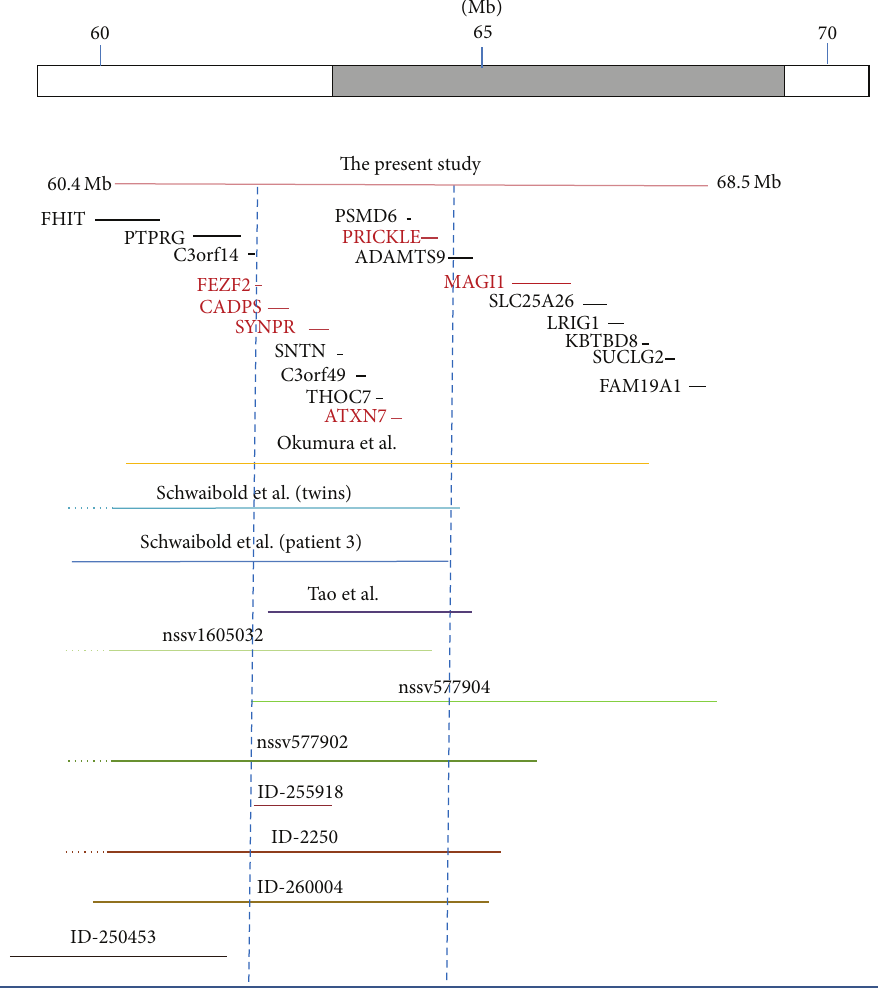
Figure 3: Schematic representation of the 3p14 deletions. The orange line represents the deletion in our patient. The deletions found by Okumura et al., Schwaibold et al., and Tao et al. are represented by lines in yellow, blue, and purple, respectively. The green and brown lines are deletions described previously in ISCA Consortium and DECIPHER databases, respectively. The thin red and black horizontal lines indicate the genes that are located in the 3p14 deleted region, the red ones being those that might be responsible for the phenotypic features given their known biological functions. The blue vertical dashed lines indicate the region in which the candidate genes are located and the overlapping deleted regions in 10 of the 11